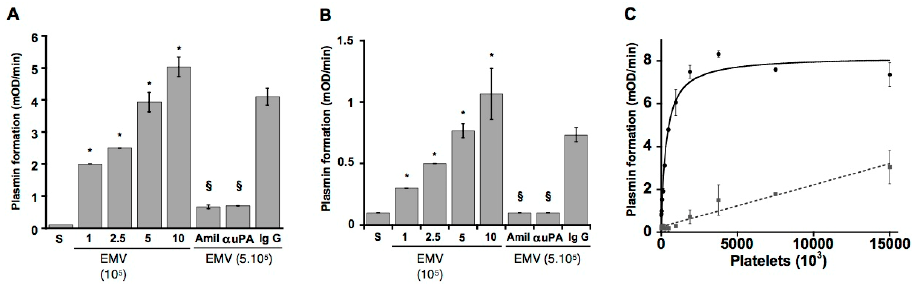
Figure 7. Fibrinolytic cross-talk between endothelial microvesicles (EMV) or cells and fibrin-, fibronectin- or platelet-bound plasminogen. Plasmin is formed when fibrin-bound plasminogen ( A ) or fibronectin-bound plasminogen ( B ) is cleaved by microvesicles carrying uPA. Plasmin formation is prevented by amiloride (Amil) and a polyclonal antibody directed against uPA ( α -uPA) as compared to the IgG isotype control. ( C ) Platelet-bound plasminogen is activated by a fixed concentration of uPA-bearing microvesicles in a platelet concentration-dependent manner until saturation. The dotted line represents non-specific activity on platelet-bound plasminogen by tPA-bearing cells (mouse cortical neurons) [95]. * Significant changes compared with activation in supernatants. § significant changes compared with activation on at 5 × 10 5 EMPs ( p < 0.05).